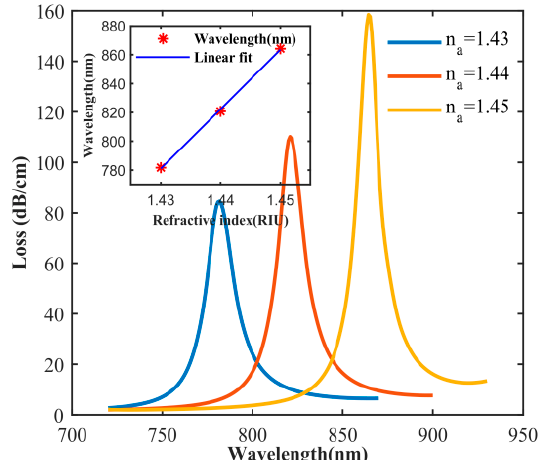
Figure 7. Influence of n a on the loss spectrum for a gold coating thickness of 50 nm (insert Figure 7 Variations of resonance wavelength with different RIs (n a ) from 1.43 to 1.45).